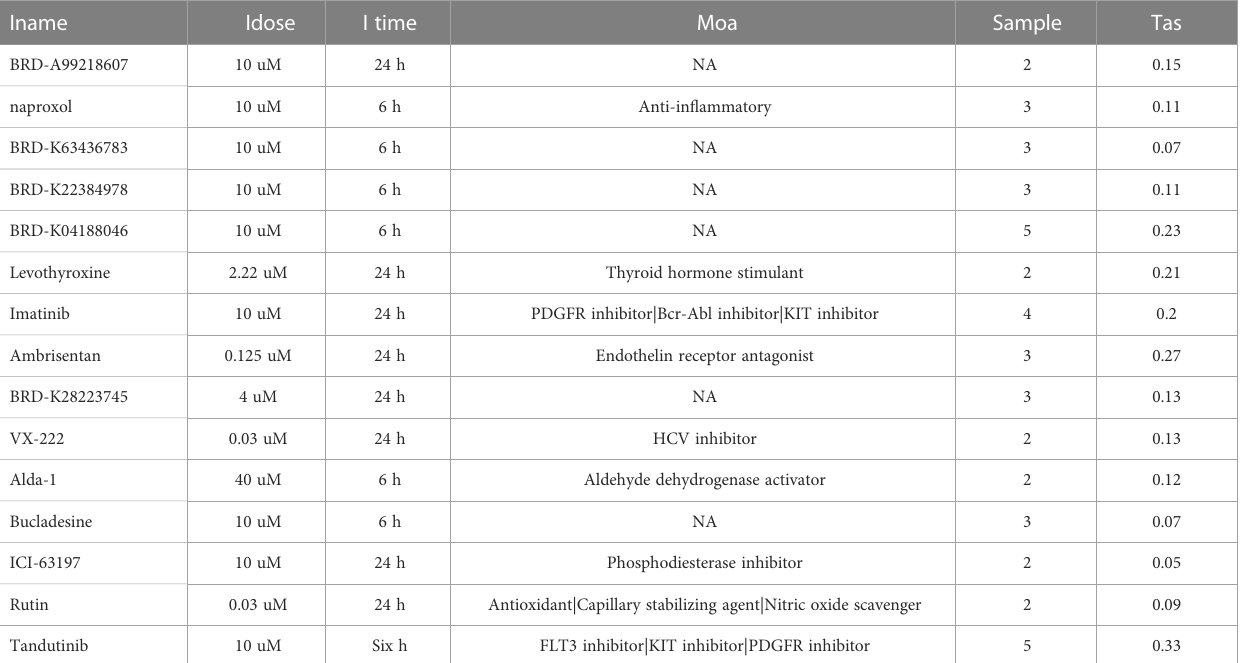
TABLE 3 Small molecules reported to inhibit Transcription factors in Table 2